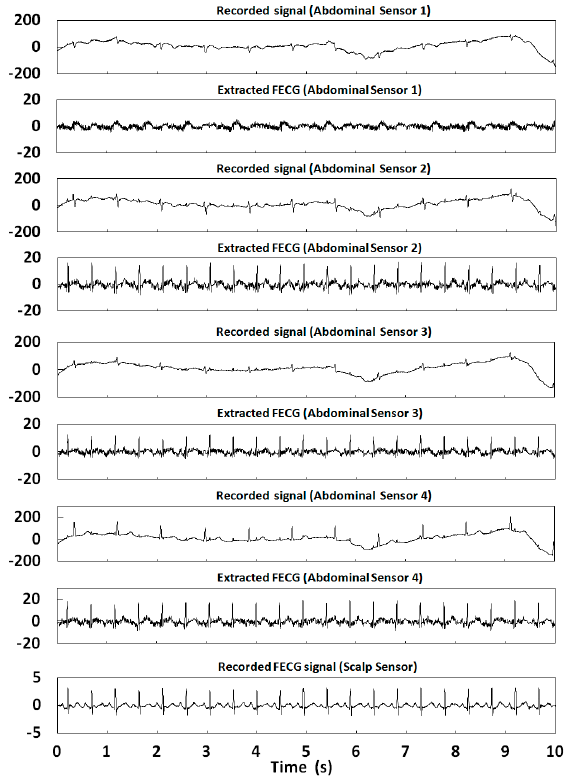
Figure 14. Extraction results for r07 in the ADFECGDB database.